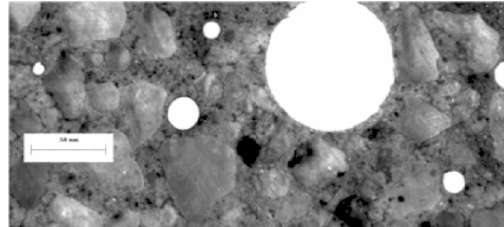
Fig. 3. Air void in non air-entrained SCC, w/b = 0.40. Scale on the figure means 0.5 mm (Szwabowski, Łaźniewska-Piekarczyk 2008)